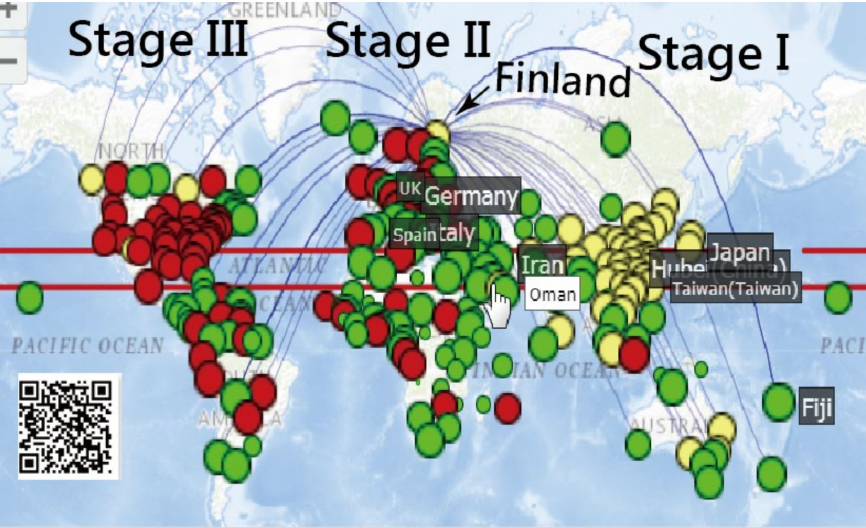
Figure 5. Finland compared to three clusters separated by SNA using the correlation pattern across three stages in yellow, green, and red, respectively. (Note: The curve means the close relation (CC > 0.8) between two countries/regions according to SNA guidelines; readers are invited to scan the QR-code to examine the detail on a